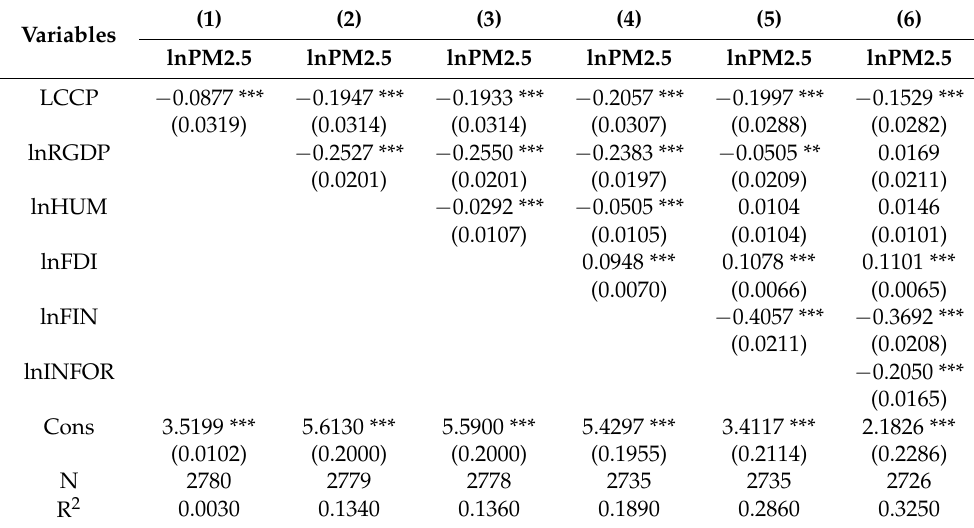
Figure 5. Kernel density function matching diagram. Table 4. Estimation results by PSM-DID